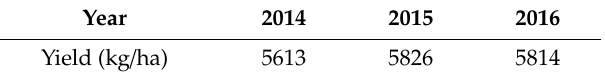
Table 2. Yield of winter wheat (2014–2016).